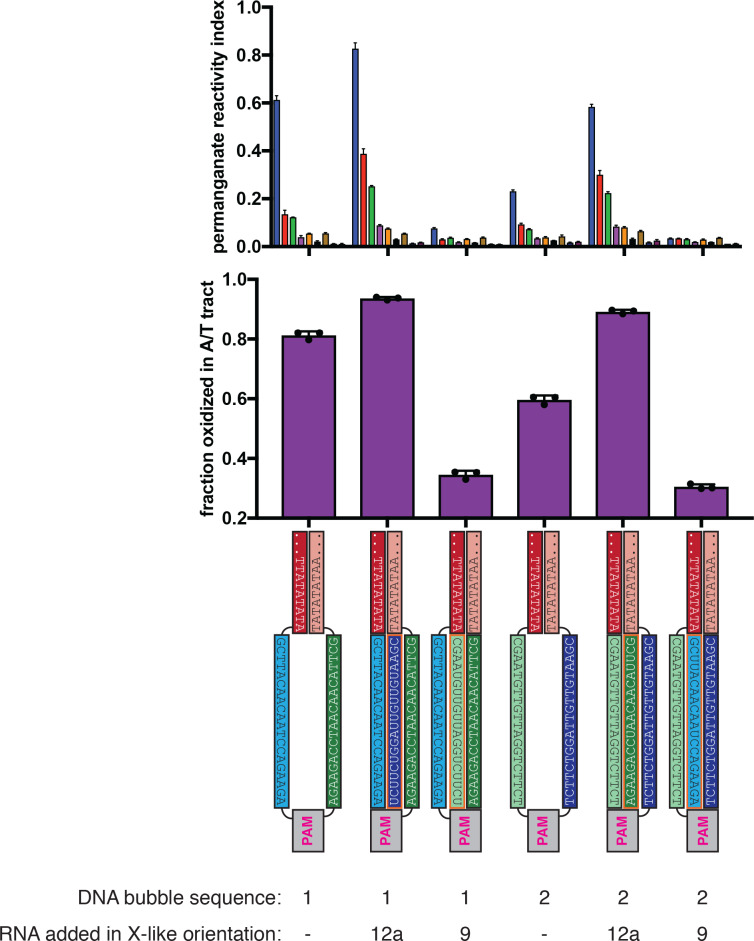
Asymmetry in R-loop flank stability is also a feature of intact R-loops.Permanganate experiments were conducted as in Figure 2B (2 minutes, 30°C). See Materials and methods for description of the parameters plotted on the y-axis. Columns and associated error bars indicate the mean and standard deviation of three replicates. In all schematics, RNA molecules are outlined in orange, and DNA molecules are outlined in black. All sequences, when read right-side up, go from 5′ on the left to 3′ on the right. These experiments provide the strongest point of comparison between the Cas12a-like and Cas9-like R-loop architecture, as the only component varied across conditions is which strand of an identical DNA bubble is hybridized to RNA (compare the cleaved R-loops, in which the position of the gap must be moved to the opposite strand, yielding slightly different baseline permanganate reactivity).